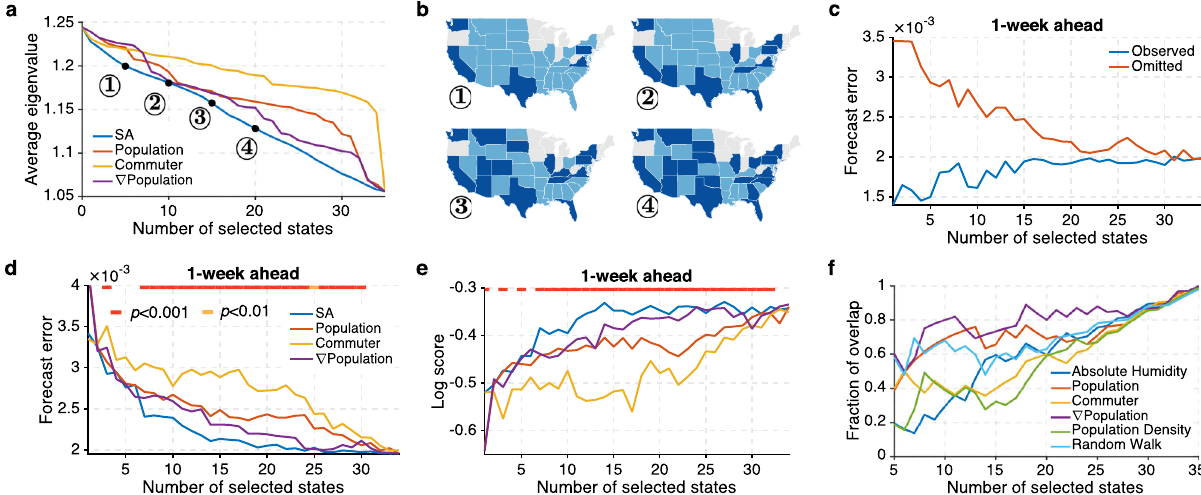
Fig. 3 Surveillance network optimization for 35 US states. a The average eigenvalues of surveillance networks selected by SA (simulated annealing) (blue line), population (red line), commuter numbers (orange line), and population gradient ( ∇ Population) (purple line). Four SA surveillance networks are displayed in ( b ). Dark blue states are selected by the SA optimization. Grey states were not included in the analysis. c Forecast error for 1-week ahead ILI + prediction in the observed (blue line) and omitted (red line) states. Surveillance locations are selected by SA. d Forecast error for 1-week ahead ILI + prediction using surveillance networks designed by different methods. The horizontal bar on top indicates the statistical signi fi cance for SA outperforming all other methods (two-sided Wilcoxon signed-rank test; red: p < 0.001, orange: p < 0.01, none: p ≥ 0.01). e Log score for 1-week ahead ILI + prediction using surveillance networks designed by different methods. f Overlap between the states selected by SA and those selected by other attributes: absolute humidity (blue line), population (red line), commuter (orange line), ∇ Population (purple line), population density (green line), and random walk centrality (light blue